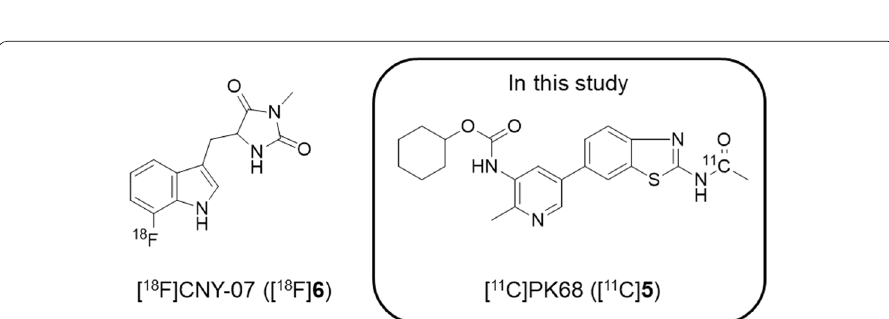
Fig. 2 Chemical structures of current radiotracers for imaging receptor‑interacting protein 1 kinase